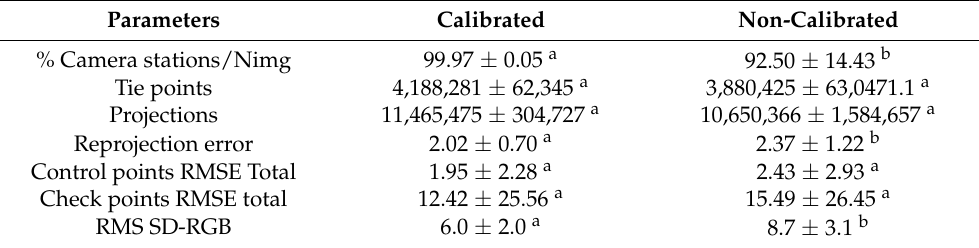
Table 3. Mean (±SD) values of the parameters obtained after orthophoto reconstruction. Differences between the calibrated and non-calibrated reconstructions. Means with the same letter are not significantly different (Wilcoxon paired test).